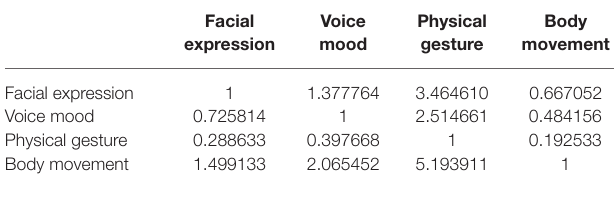
TABLE 2 | Scale for comparison of factors in